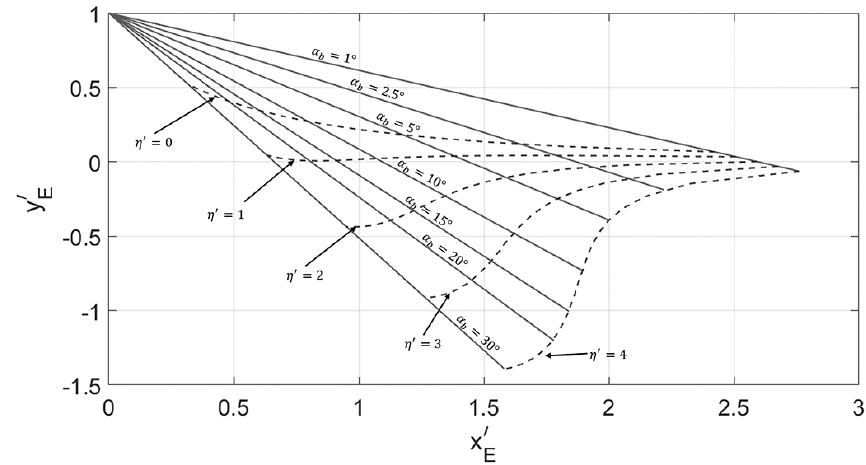
= x E /y g and y (cid:48) = y E /y g for maximum indentation point, based on the dimensionless variable η (cid:48) = η/y g Figure 8. Location of x (cid:48) E E